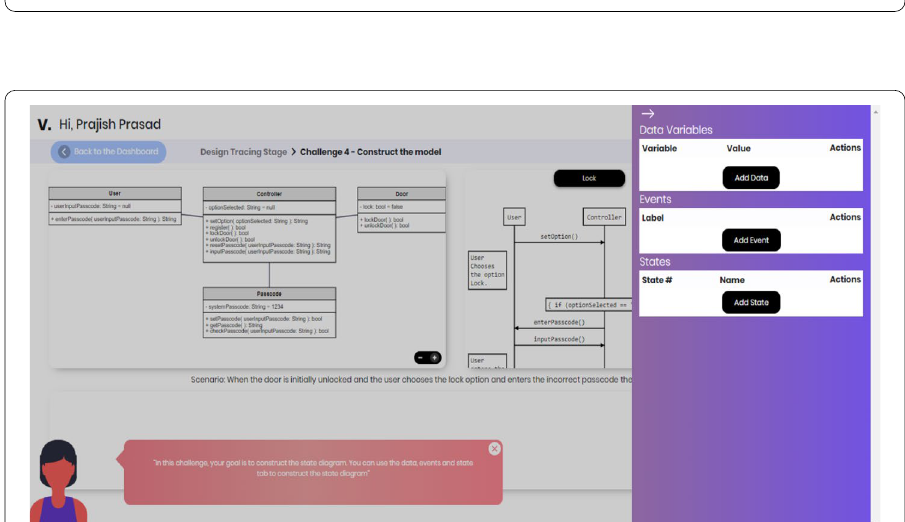
Fig. 8 In Challenge 4, learners construct the entire state diagram from